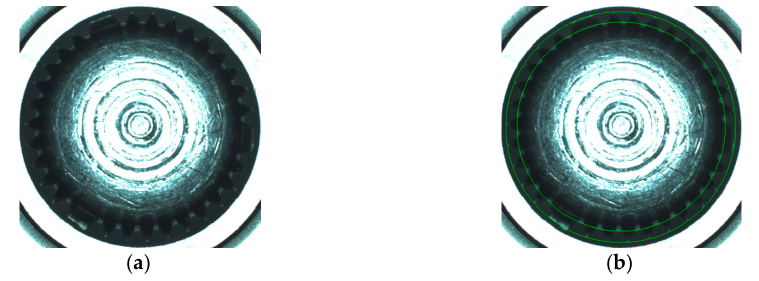
Figure 12. Fitting the spline circles by CAM: ( a ) Image of spline; ( b ) Detection results of inscribed and circumscribed circles of spline (denoted by green circles).